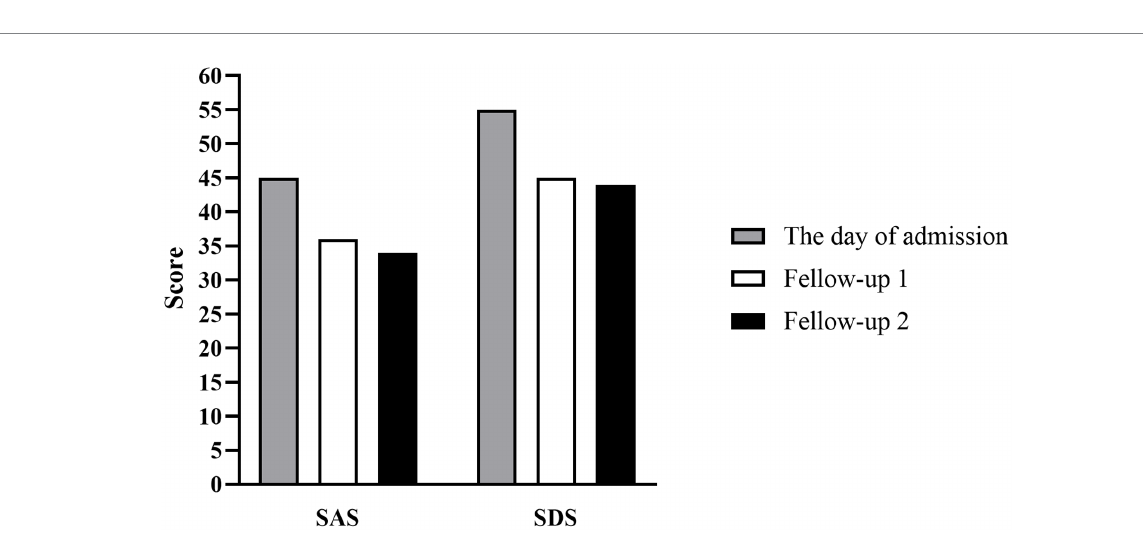
FIGURE 3 Histogram depicting score changes on SAS and SDS at three time points. The day of admission: May 15, 2020; Fellow-up 1 and 2: June 23, 2020 and August 15, 2020,